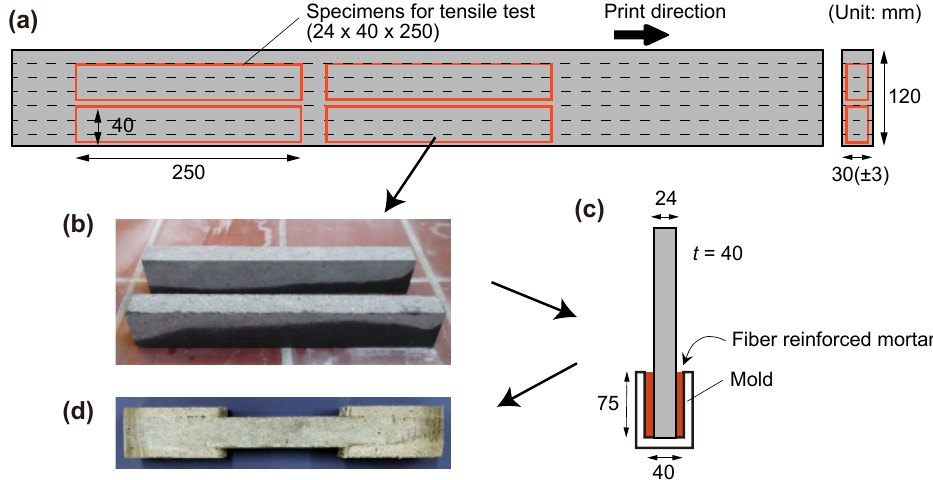
Figure 3. Preparation of specimens for tension tests: ( a ) position of the specimens in the printed wall; ( b ) cut specimens; ( c ) reinforcement for the specimens’ ends; and ( d ) specimens after